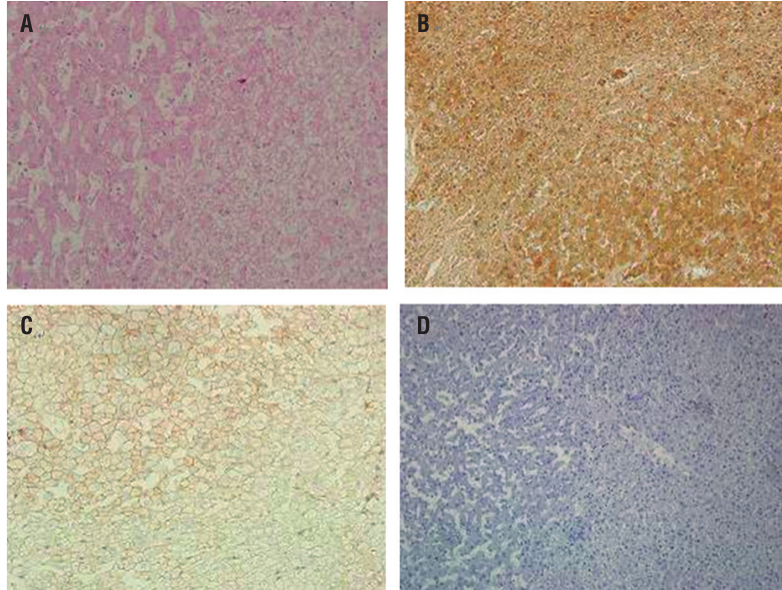
Figure 1 - Immunohistochemistry analyses (200X). (A) Hematoxylin and eosin (H&E) stain; (B) L-FABP immunostaining. Cytoplasmic and nuclear L-FABP expression was present in the tumor; (C) β -catenin immunostaining. β- catenin–inactivated normal membranous staining of hepatocytes was similar in the tumor and non-tumor liver; (D) SAA immunostaining. SAA staining was absent in the liver specimen. These results indicate that the patient’s HA belonged to the no mutation, no inflammation HA